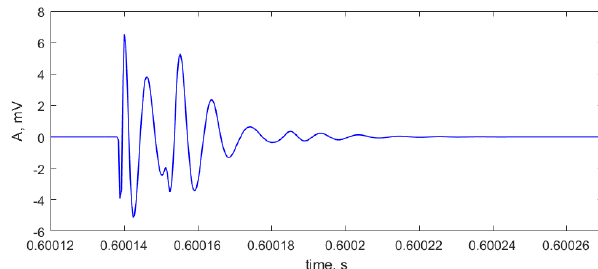
Figure 6. Typical shape of a single.